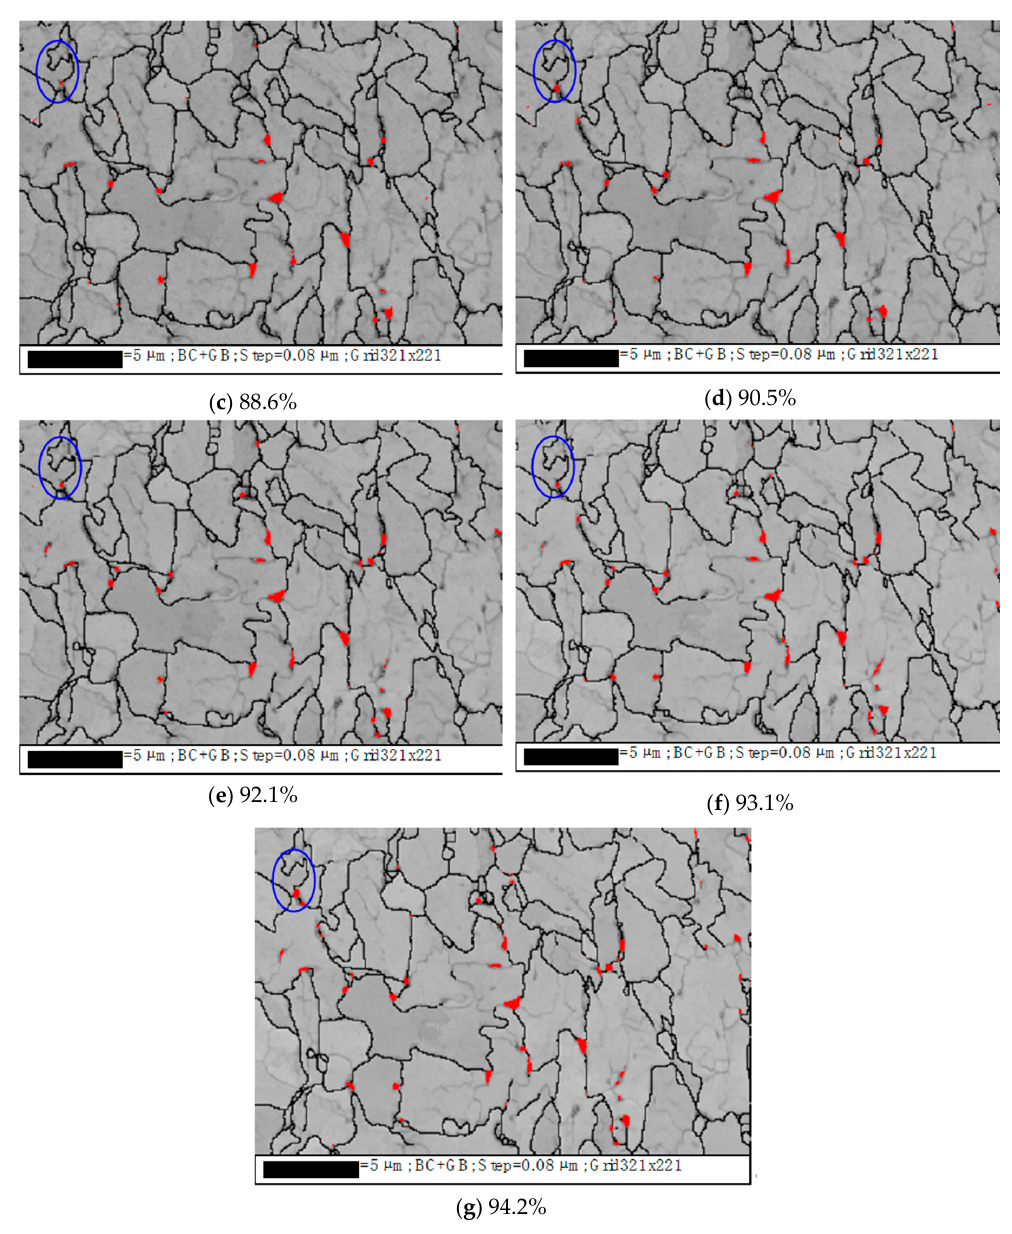
Figure 3. The morphology and distribution of retained austenite in X90 steel at different indexing rates ( a : 80.7%; b : 85.1%; c : 88.6%; d : 90.5%; e : 92.1%; f : 93.1%; g : 94.2%).